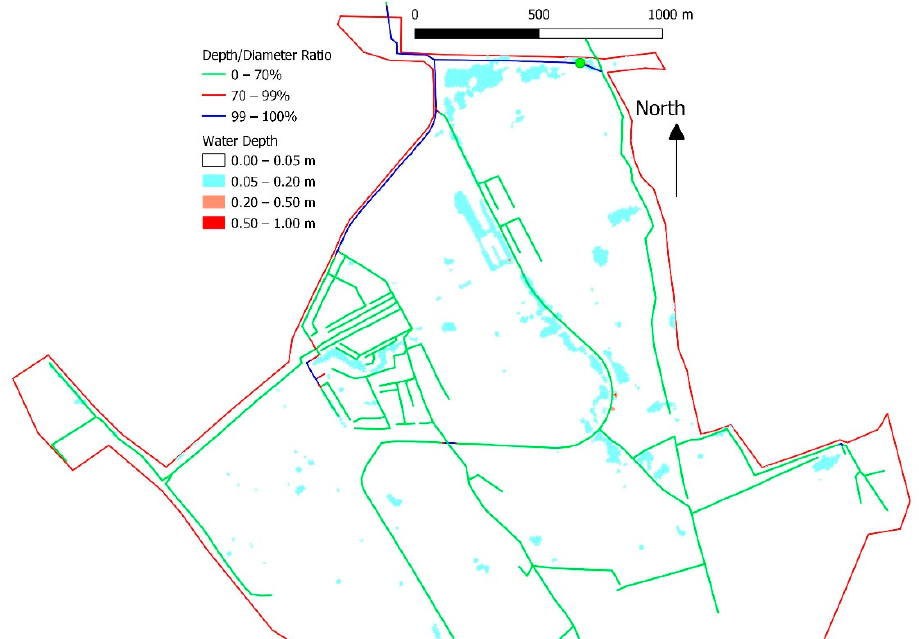
Figure 10. Results of event of 1 October 2021 (rain 7.8 mm). Part-full pipe flow (green line) and surcharging pipe (blue lines). The green point indicates the local overflow at Piazza Castelforte. In the two calibration events, for n s < 0.018 m − 1/3 s, at Piazza Castelforte storm overflow